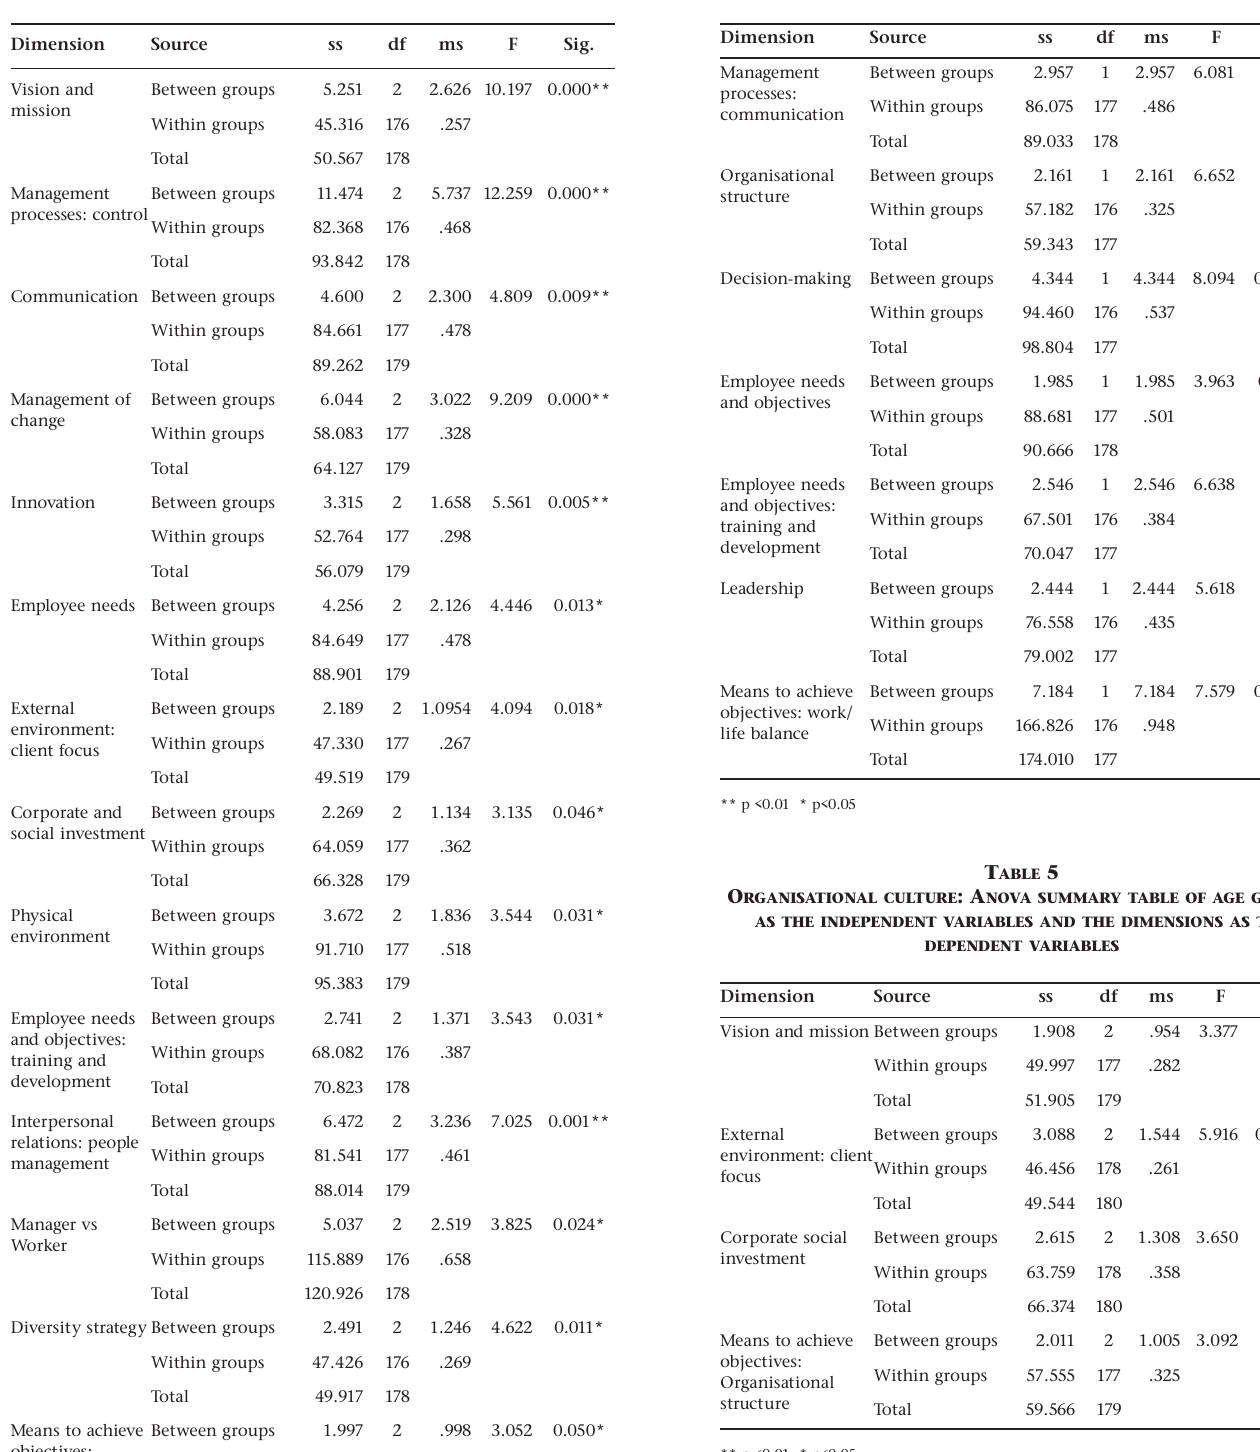
T able 4 o rganisaTional culTure : a nova summary Table of race groups as The independenT variables and The dimensions as The dependenT